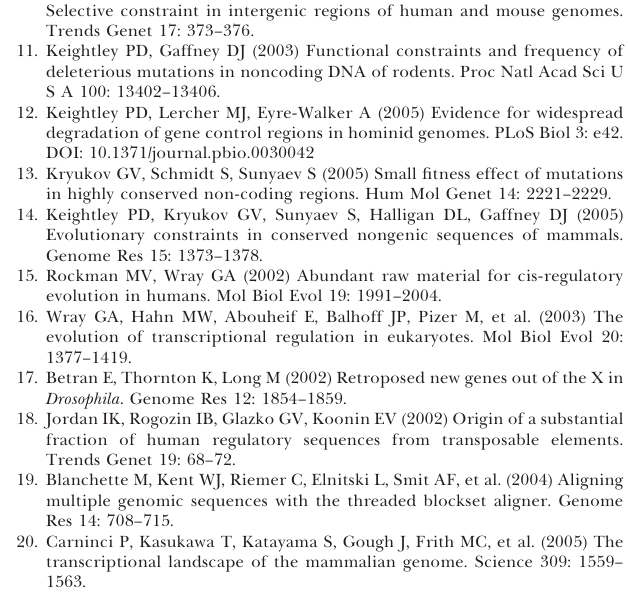
Figure S3. Pairwise Substitution Rate Estimates in the Immediate Vicinity of the TSS for 5 9 and Internal Promoters Results are displayed for 5 9 promoters (5p) in red and for internal promoters (int) in blue, for three different species comparisons. In all data the TSS is at position þ 1, indicated by a grey vertical line. Error bars show 95% confidence intervals. Found at DOI: 10.1371/journal.pgen.0020030.sg003 (38 KB PDF). Figure S4. Influence of TATA Boxes on Promoter Evolutionary Rate Profiles (A) The 5 9 -most position of matches to a TATA-box profile across human promoter regions. The x -axis indicates position, with the TSS at þ 1; the y -axis shows the number of promoters with a significant match to the TATA-box profile (see Materials and Methods). (B) The same data as in (A) but focussed in on the region immediately around the TSS. A clear and sharp peak is evident at (cid:1) 33 to (cid:1) 27, showing great consistency in the spacing between the TATA box and the dominant TSS. (C) The substitution rate calculated per nucleotide across human promoters based on human–mouse alignment. The subset of promoters that match the TATA-box profile in the nucleotide range (cid:1) 33 to (cid:1) 27 are shown in blue, and those without a TATA-box match are shown in red. Error bars indicate 95% confidence intervals. (D) The same data as in (C) but focussed in on the region immediately around the TSS. The significant reduction in substitution rate around (cid:1) 30 is confined to sequences with a TATA-box match. Found at DOI: 10.1371/journal.pgen.0020030.sg004 (34 KB PDF). Table S1. Substitution Rate Estimates for Human Promoters after Masking for CpG Substitution Effects All nucleotides preceding a cytosine or following a guanine in human sequence were masked in the alignments prior to substitution rates being calculated, as described in Materials and Methods. The 95% confidence intervals are shown in parentheses. Table S2. Relative Selective Constraint in Mouse and Human Coding and Core Promoter Sequences